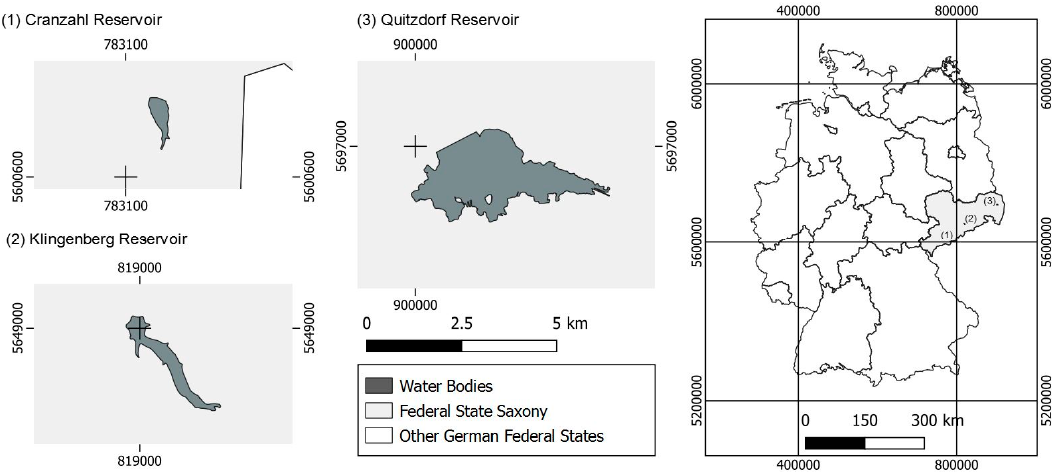
Figure 2. The locations and shapes of three investigated water bodies in Saxony, Germany. Projection and coordinate system: ETRS89/UTM32N, EPSG: 25832.